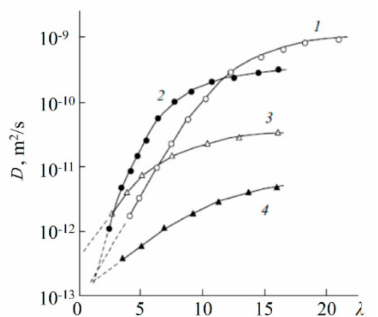
Figure 50. Effect of the diffusant content on the diffusion coefficients of water (1), methanol (2), ethanol (3), propanol (4) in the Li+-form of perfluorinated membrane MF-4SC m is the number of diffusant molecules per sulfonate group (adapted from